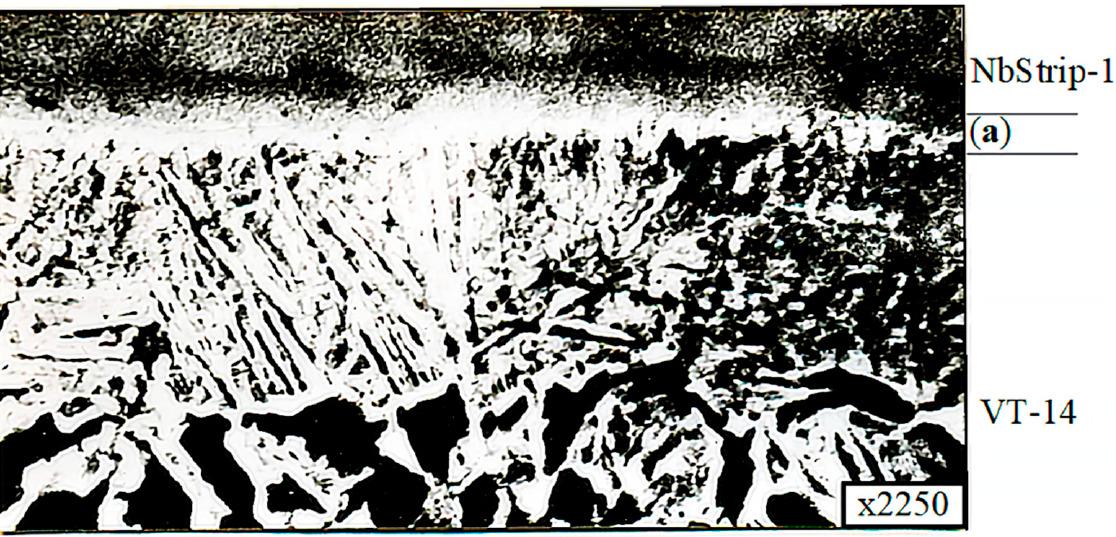
Figure 19. Niobium-titanium compound (secondary electrons): ( a ) the zone characterized by an altered structure. Electron microscopic studies were carried out on microsections of the VT-14+NbStrip- 1+M1+12KH18N10T welded joint. These were obtained by diffusion welding under op- timal conditions. The studies were carried out on a REM-100U electron microscope. To reveal the microstructure, the metals were chemically etched with reagents. The results showed that in the NbStrip-1+VT-14 connection zone, a zone characterized by an altered structure (a diffusion zone) with a width of 0.011 mm was found (Figure 15). Moreover,